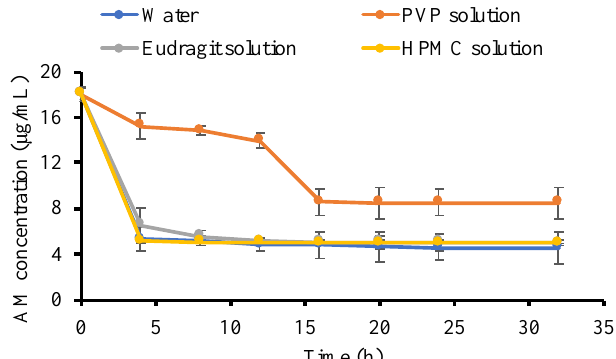
Figure 5. The concentration of AM in the phosphate buffer at pH 7.4 and each polymer solution n = 3, mean ± standard deviation).